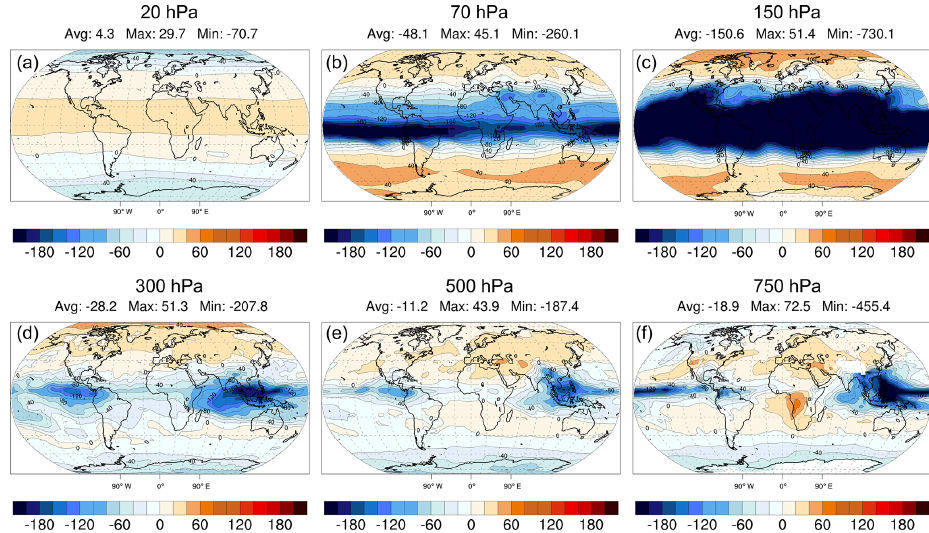
Figure 7. Relative average differences between the control simulation and the SOFRID a priori profile on July 2010. Values are given as percentages (%) of the control simulation (Fig. 6). Same plots as in Fig.